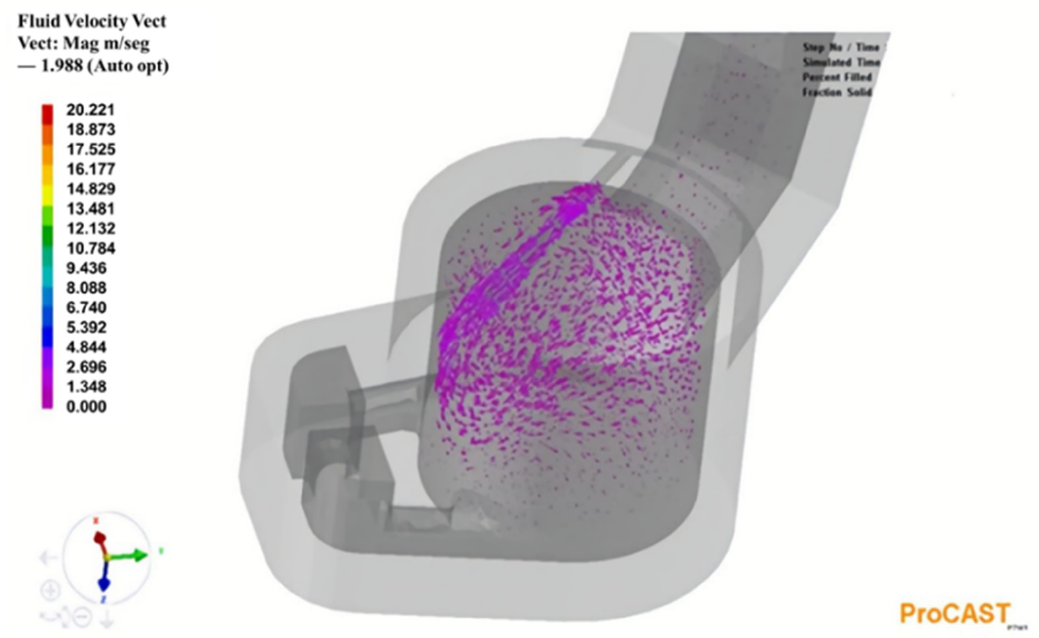
Figure 5. Velocity vectors of the flue gases for a burner position of 45° related to the horizontal line, for a simulation time of 5200 s.